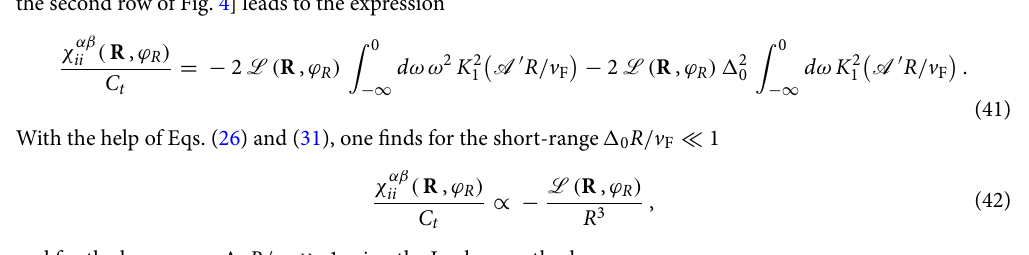
( R , ϕ R )/ J 2 C t as a function of R for different J RKKY αβ − 0 , ( b ) ϕ 6 and ( c ) ϕ 4 R = π/ R = π/ =